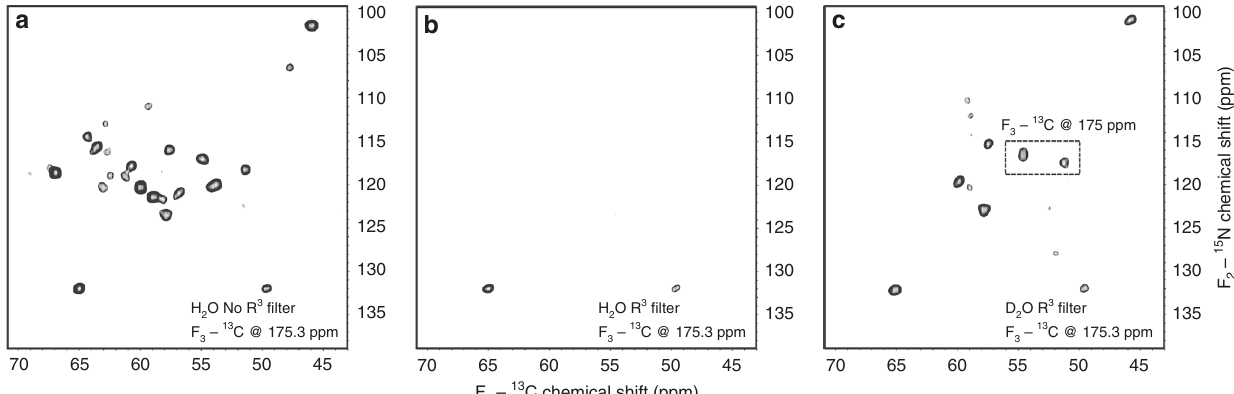
Fig. 3 Representative 2D planes of the 3D R 3 -CANCO spectra. a Reference spectrum collected without R 3 fi lter in the H 2 O based buffer. b Spectrum collected with R 3 fi lter in the H 2 O based buffer. Only peaks corresponding to prolines are detected. c Spectrum collected with R 3 fi lter after incubation in the D 2 O based buffer at 20°C. Several peaks corresponding to exchanged residues reappear. Residues shown in the dashed box undergo a slight isotopic shift of ~0.3 ppm in the carbonyl chemical shift dimension. All spectra were collected on sample 1. The fi rst contour is at 5 times root-mean-square of